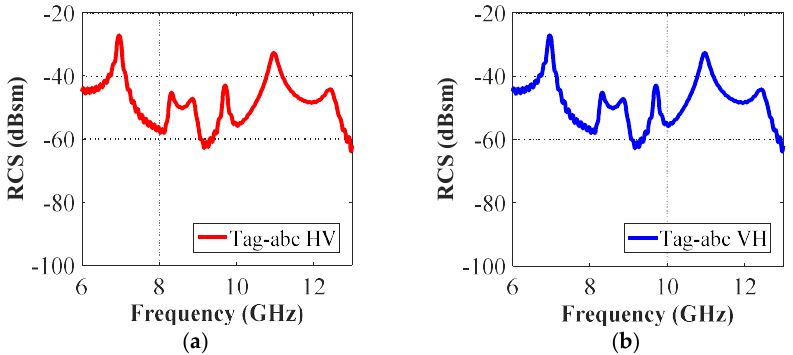
Figure 14. Cross-polar RCS simulation results of tag-abc: ( a ) Cross-polar HV RCS responses; ( b ) Cross-polar VH RCS responses.